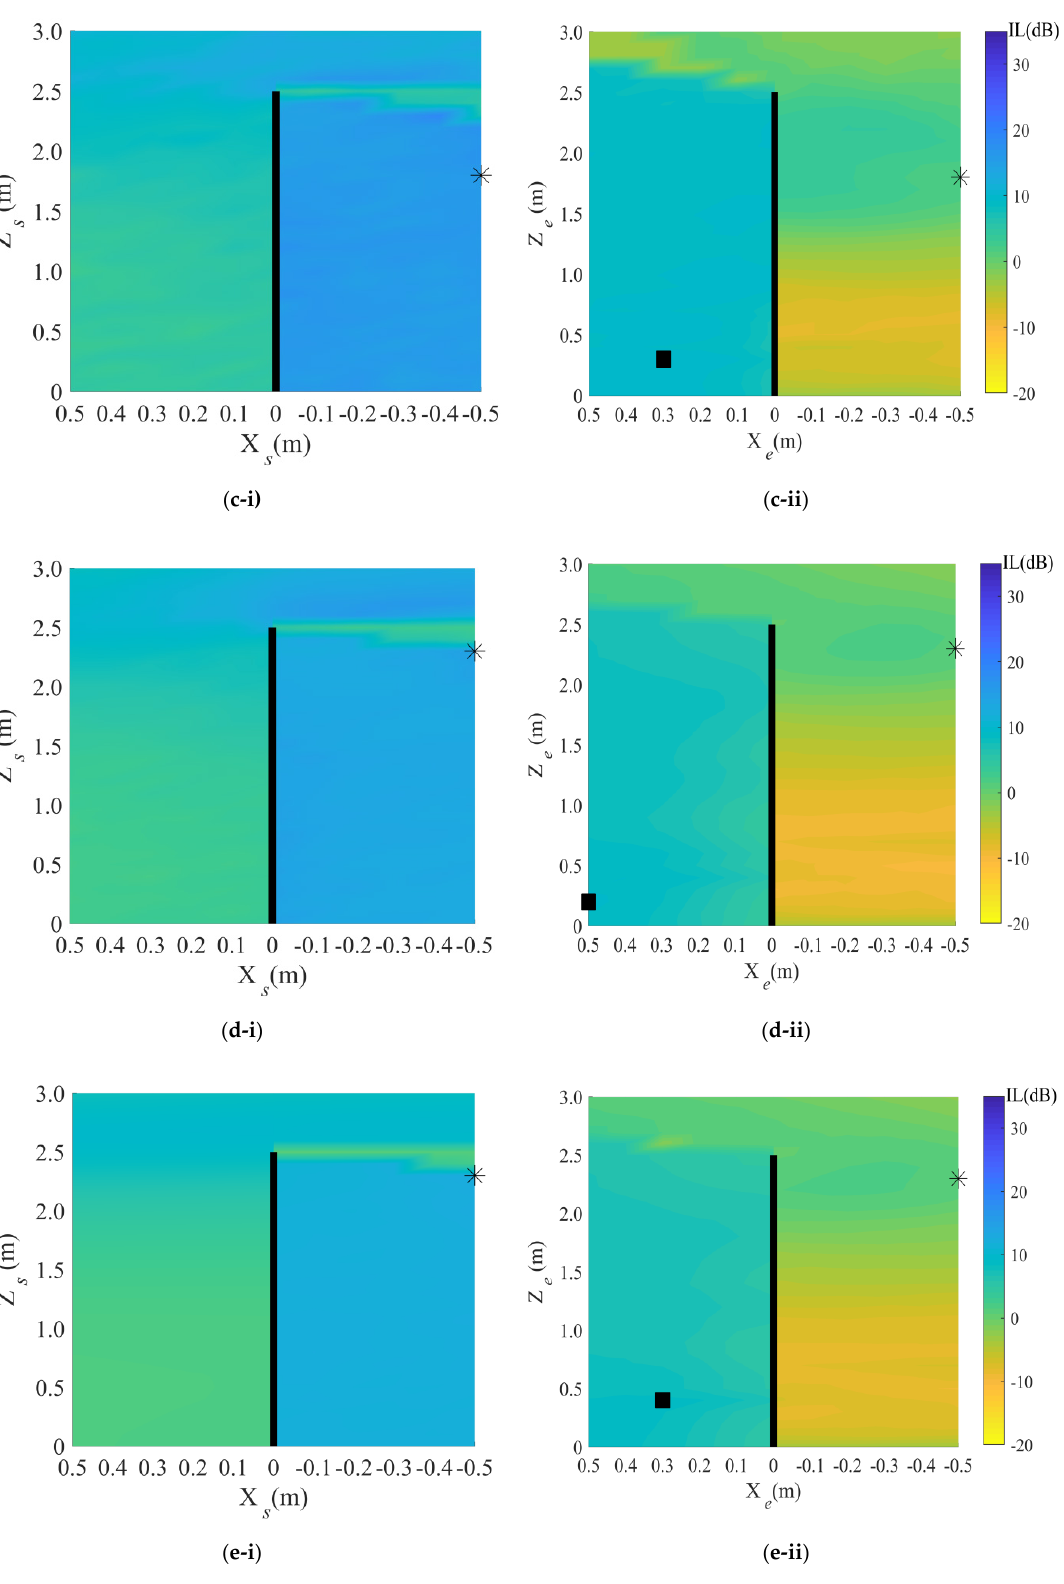
(dB) for different positions of ( i ) secondary sources and ( ii ) error microphones in the Figure 5. Figure 5. IL FS (dB) for di ff erent positions of ( i ) secondary sources and ( ii ) error microphones in the ) is ( a ) 1 m, ( b ) 2.5 m, ( c ) 4 m, ( d ) 5.5 m, and ( e ) 7 m. control zone. The distance of the noise source ( control zone. The distance of the noise source ( d pr ) is ( a ) 1 m, ( b ) 2.5 m, ( c ) 4 m, ( d ) 5.5 m, and ( e ) 7 m. 𝐼𝐼𝐼𝐼� 𝑂𝑂𝐹𝐹 * and ■ represent the best positions of the control sources and error microphones, respectively. * and (cid:4) represent the best positions of the control sources and error microphones, 𝑑𝑑 𝑝𝑝𝑟𝑟